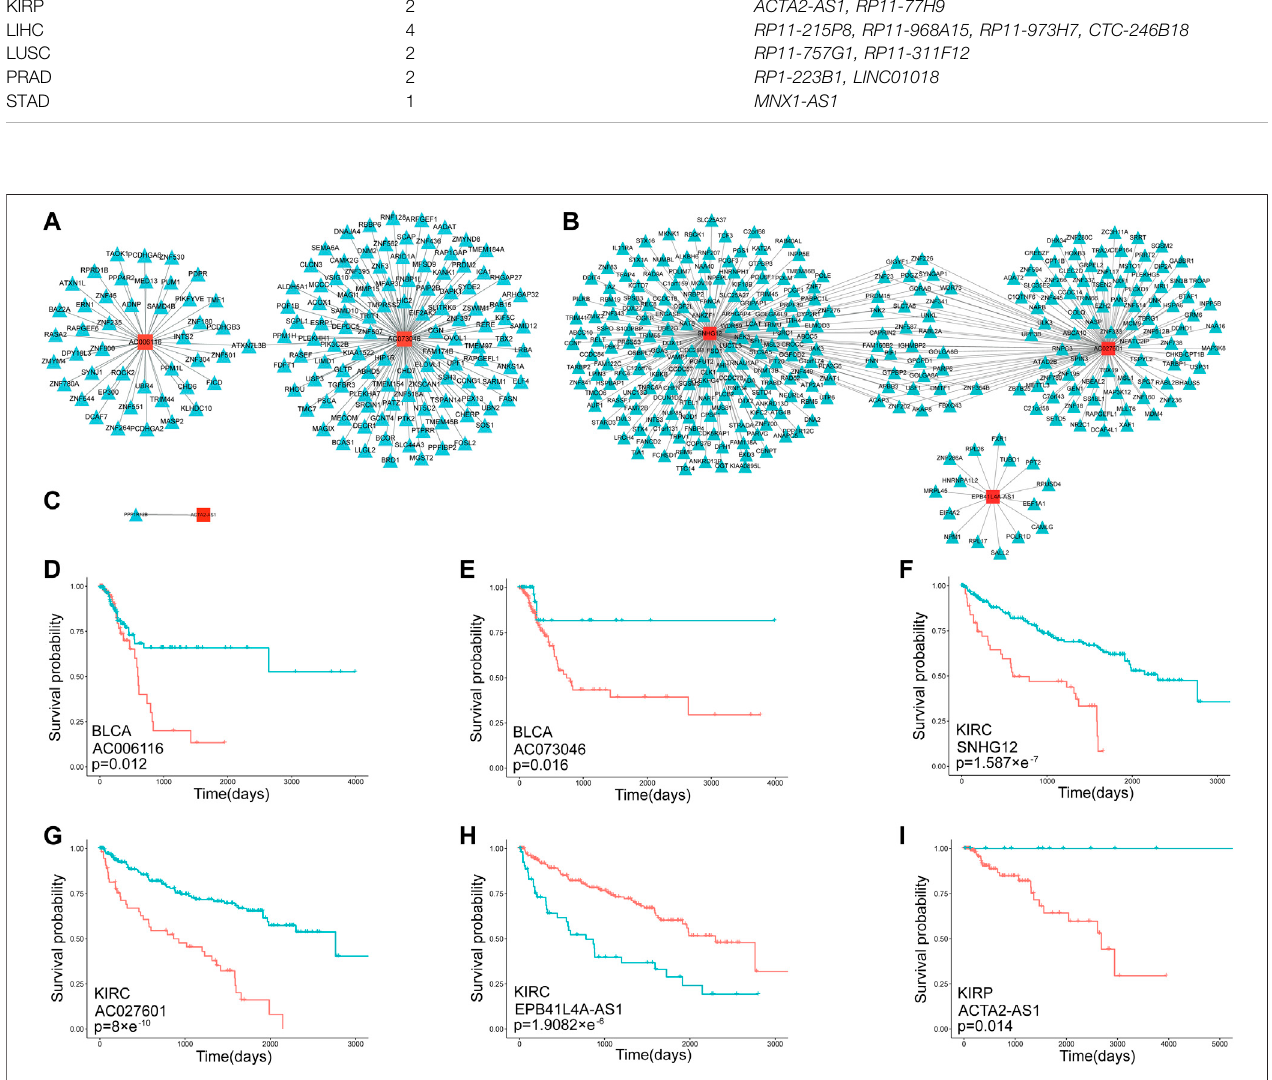
Table 5 , 29 lncRNAs were identi fi ed to associated with survival in ten cancers. These lncRNAs may be used as